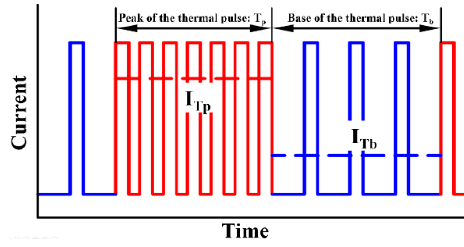
Figure 1. Schematic diagram of current waveform of double-pulsed gas metal arc welding (DP-GMAW).